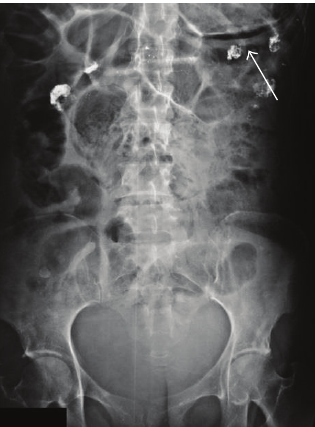
Figure1:PlainabdominalX-ray.Radiolucentimageintheupperleft abdominal quadrant, showing the presence of air within the wall of the stomach (arrow).